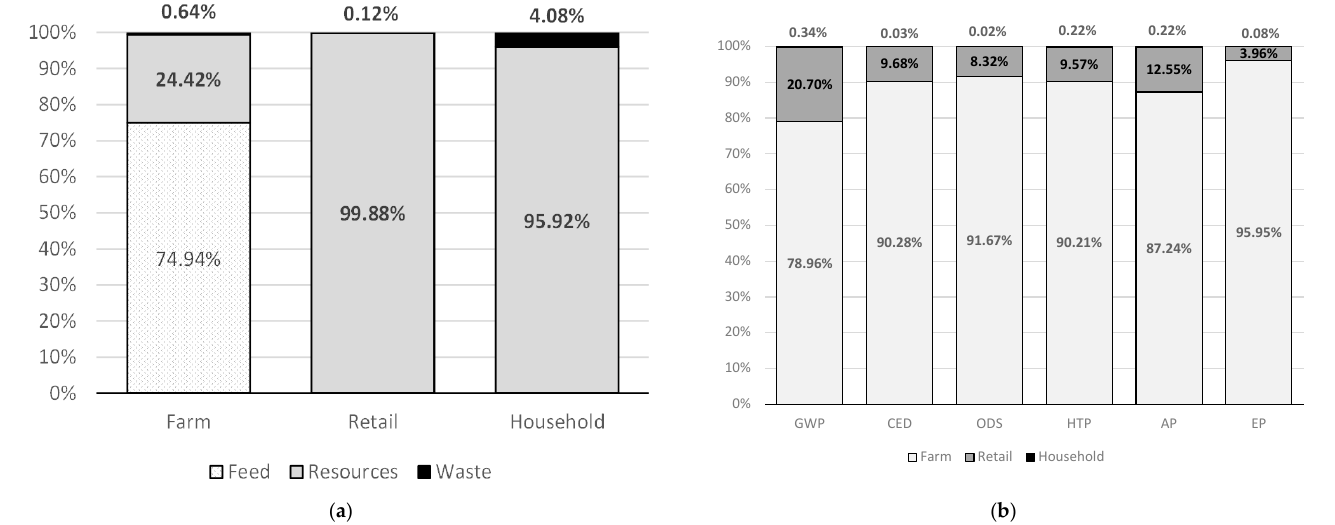
Figure 2. Life cycle of the egg supply chain; ( a ) Relative contributions (in %) to global warming potential from processes involved in the three subsystems—farms, retailers and households; ( b ) Relative contributions (in %) to environmental impacts from the three subsystems—farms, retailers and households. Legend: Resources—water and all types of energy; Waste—all types of waste and wastewater; GWP—global warming potential; CED—cumulative energy demand; ODS— ozone depletion substances; HTP—human toxicity potential, AP—acidification potential, EP—eutrophication potential.